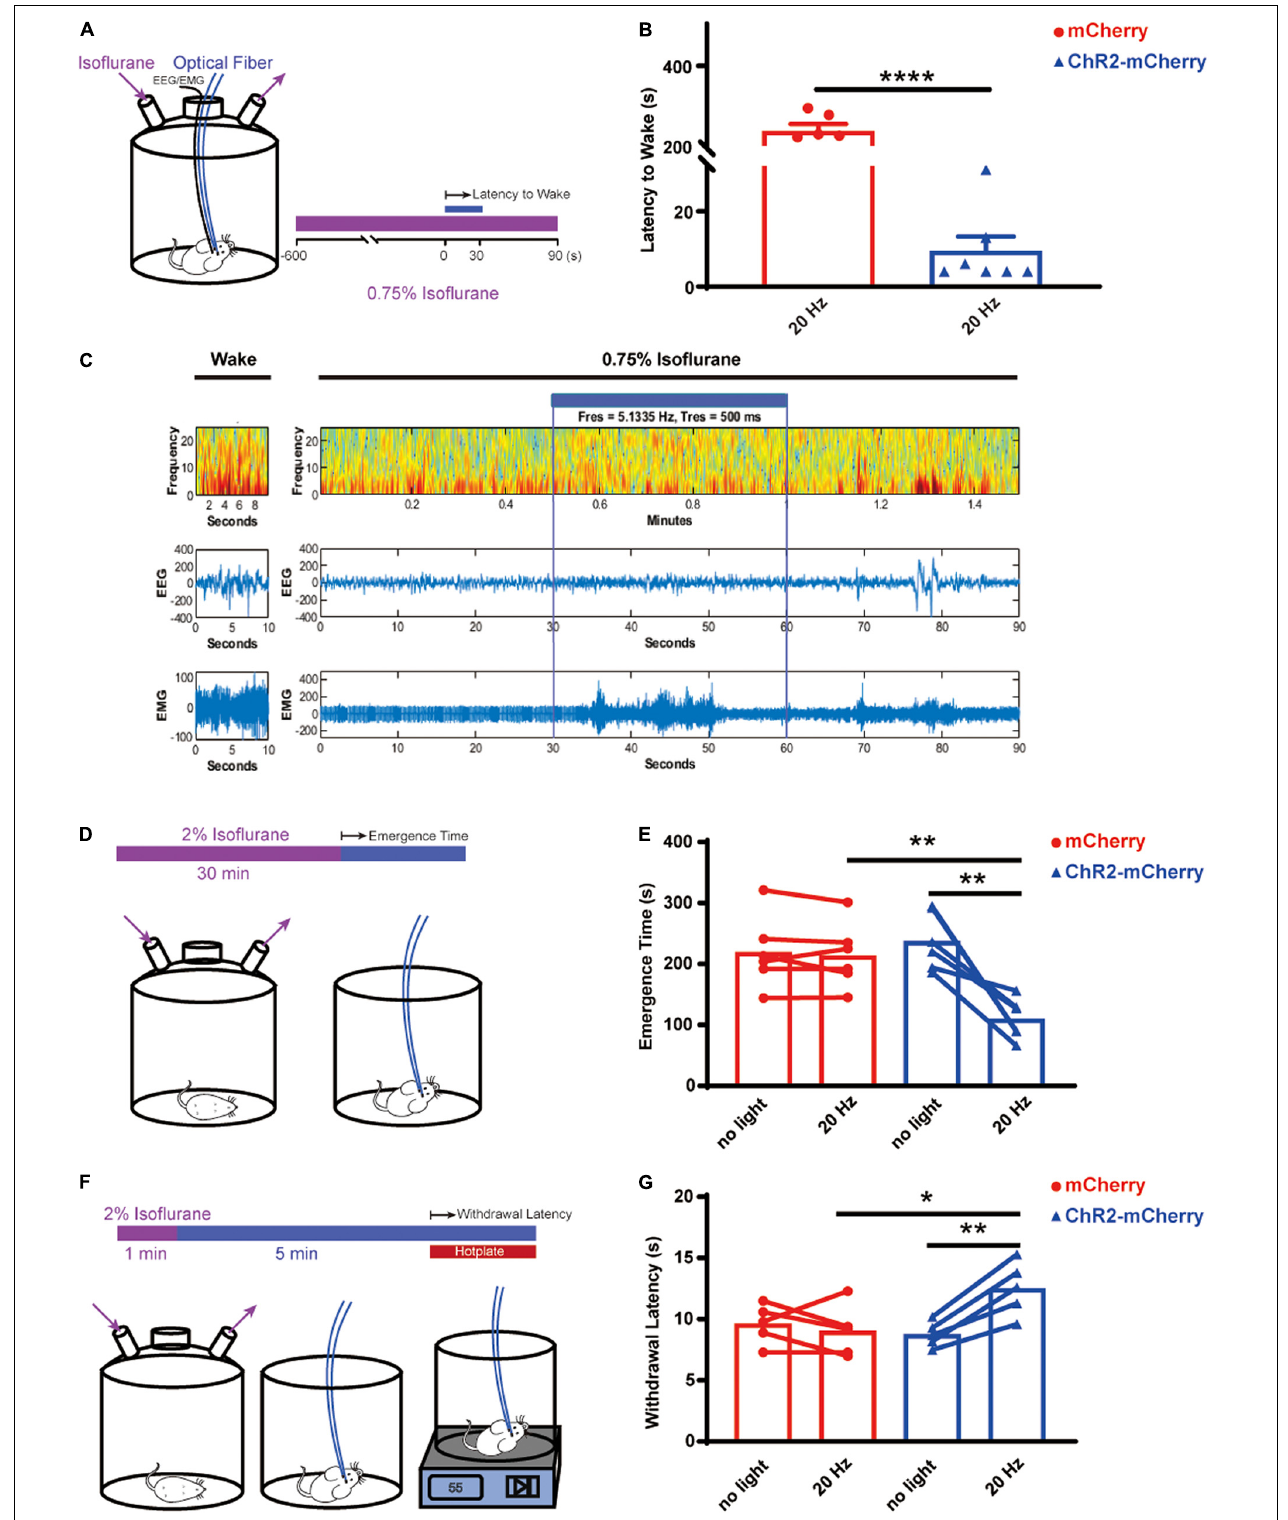
FIGURE 6 | Optogenetic activation of orexin neurons facilitated arousal and pain tolerance. (A) Arousal test under 0.75% isoflurane. (B) Optogenetic stimulation elicited early arousal, while under 0.75% isoflurane, for the ChR2-mCherry group (9.429 ± 3.804, n = 7) but not the mCherry group (238.2 ± 17.42, n = 6).